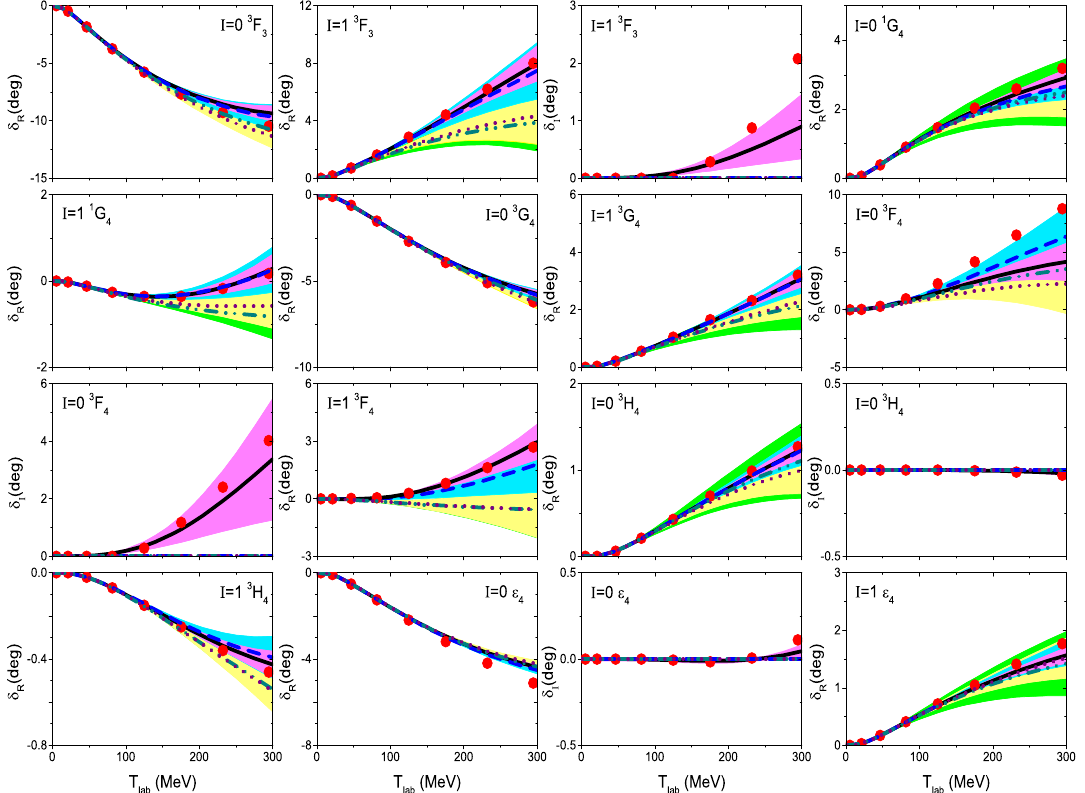
Figure 8 . Real and imaginary parts of various (cid:22) NN phase shifts for the potential with cuto(cid:11) R = 0 : 9 fm. Notations are described in the